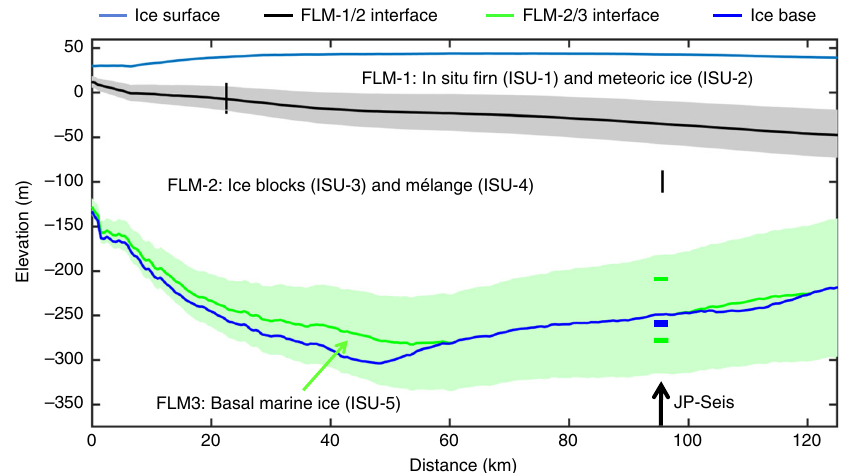
Fig. 5 Modelled fl owline along the JP suture zone. The tip of the JP is located at distance 0 km and JP-Seis is at 95 km, as labelled. The continuous horizontal blue lines represent the ice-shelf surface and base. The continuous horizontal black line represents the simulated interface between the in situ fi rn (ISU-1) and meteoric ice (ISU-2) layers accumulated on the shelf (layer FLM-1 in our fl owline model) and the upper surfaces of the glacier-derived ice blocks (ISU-3) and mélange (ISU-4) (layer FLM-2). The horizontal green line represents the simulated ‘ marine ice interface ’ between these ice blocks/ mélange and the basal marine ice (layer FLM-5, equivalent to ISU-5). The shaded bounds represent the cumulative sensitivity of the model to the input parameters (see ‘ Methods ’ ). The short vertical black lines represent depth estimates of the in situ meteoric interface from our GPR data, where their lengths indicate the inherent uncertainties. The short horizontal blue and green lines at JP-Seis indicate, respectively, the ice shelf base and the top and base of the basal marine ice body delineated by our seismic surveys, where line thicknesses indicate the inherent